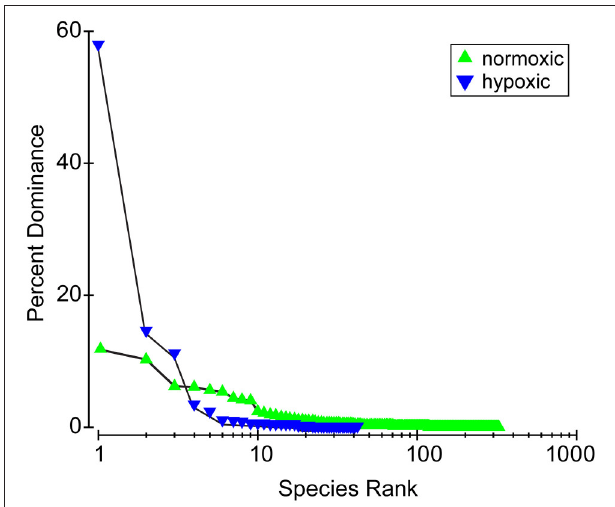
FIGURE 2 | Species dominance curves in hypoxic areas and normoxic areas. Three species dominate the hypoxic areas and the right tail of rare species contributing to biodiversity is much shorter.